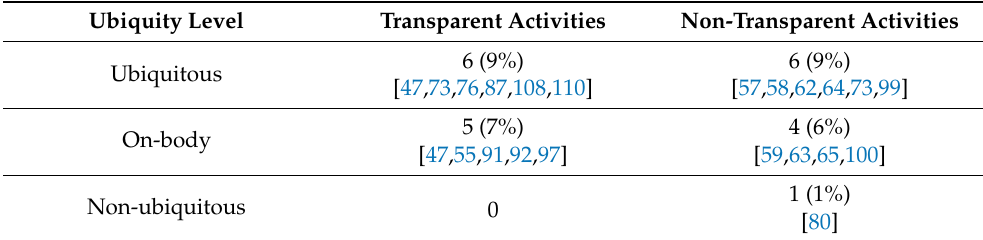
Table 6. Number of sensor-based studies assessing physical performance. The figures are displayed according to the sensors’ ubiquity and transparency levels. The figures in square brackets are the citations for the corresponding studies. The figures in brackets represent the percentage with respect to all 67 studies in the review.